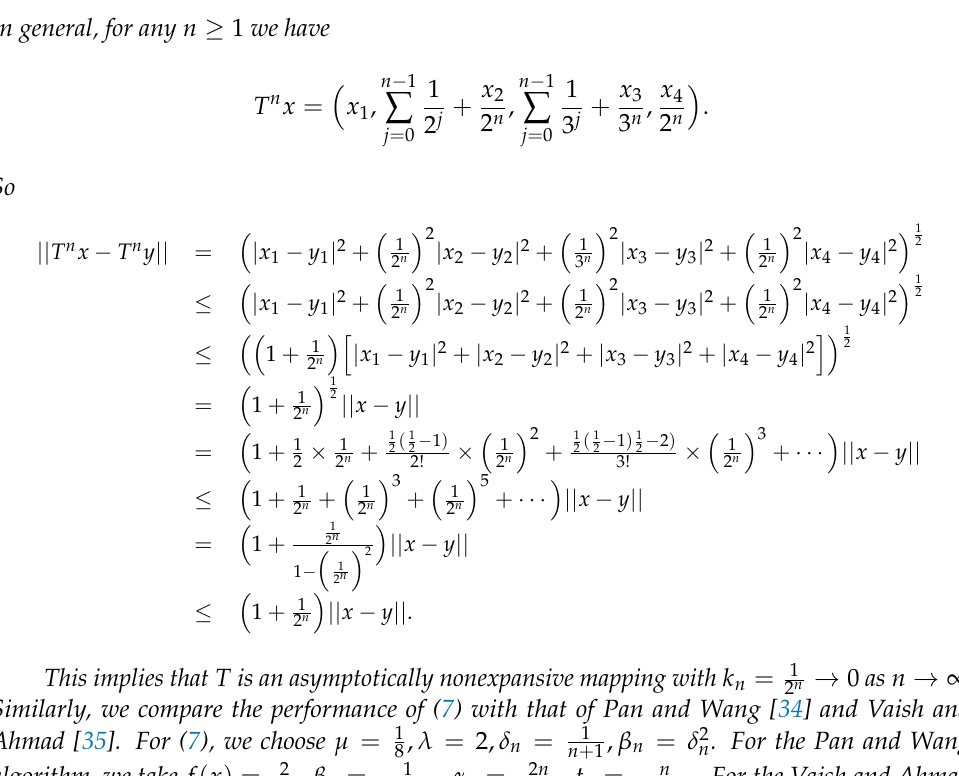
algorithm, we take g ( x ) = x